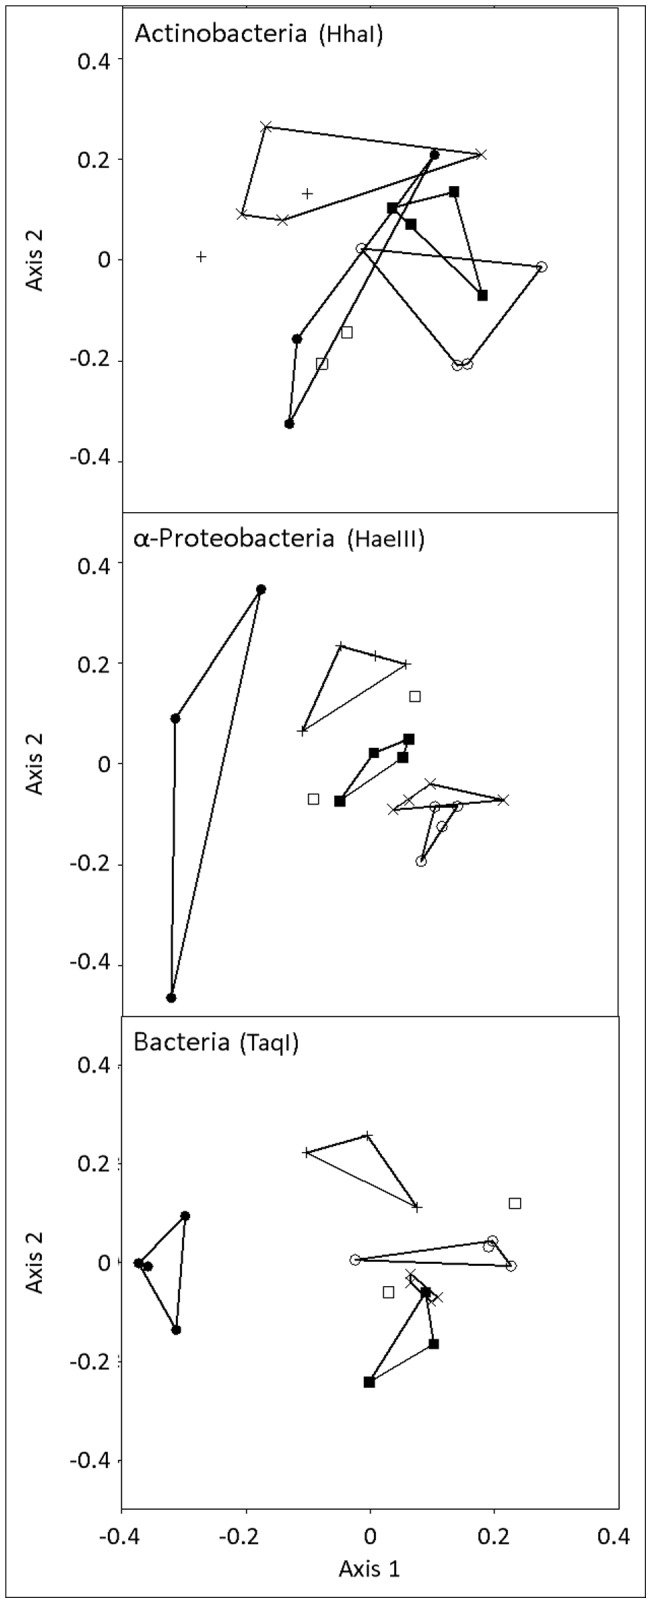
NMDS ordination of TRFLP fingerprints.Actinobacterial (top), α-proteobacterial (center) and bacterial (bottom) communities were sampled from dry Mediterranean (○), semi-arid (×), arid (▪), shoreline alluvial (□), shoreline stable sand (+) and shoreline shifting sand (•) sites. Restriction enzymes used are given in parentheses. Convex hulls connect samples from each site. NMDS axes do not possess biological meaning. Stress<12% for all ordinations, confirming a good correlation between the data and its ordination.